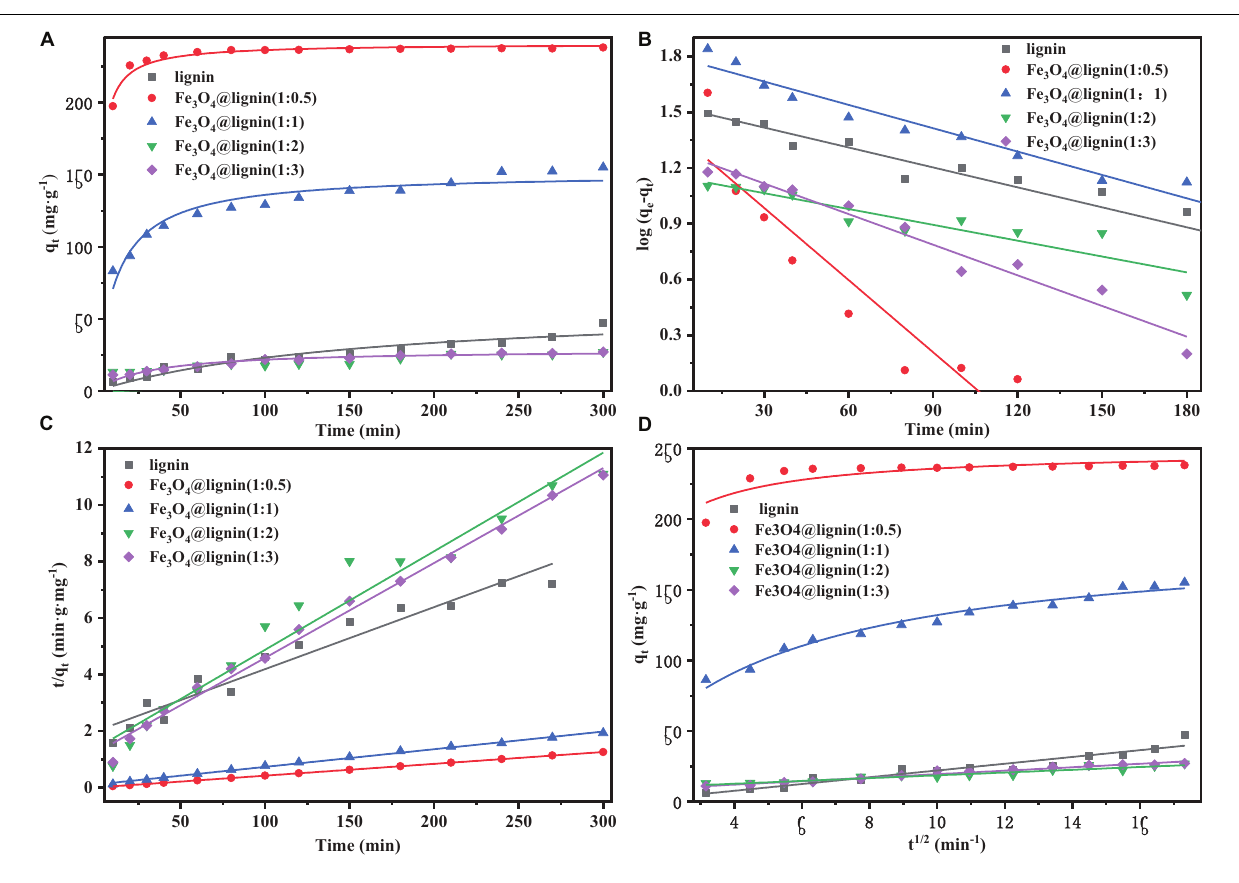
Based on the analysis of the initial concentration and adsorption time, it can be found that Fe 3 O 4 @lignin (1:0.5) is superior than other MLN to adsorb Congo red. Moreover,